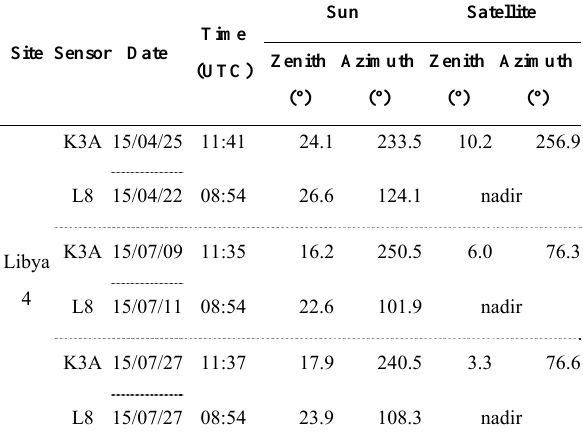
For the cross calibration, the calibration coefficient was calculated by comparing the at sensor spectral radiance for the same location calculated using the Landsat-8 calibration parameters in metadata and the DN of KOMPSAT-3A for the regions of interest (ROI). Each region of interest (ROI) for Cross calibration (Libya 4 Site) was selected to be homogenous, with a size of about 9 km × 9 km. To maintain equivalence in the pixel size between KOMPSAT-3 and Landsat-8 images, the KOMPSAT-3A images were resampled to a 30-m pixel size from their original 2.4-m resolution for multispectral bands using bilinear